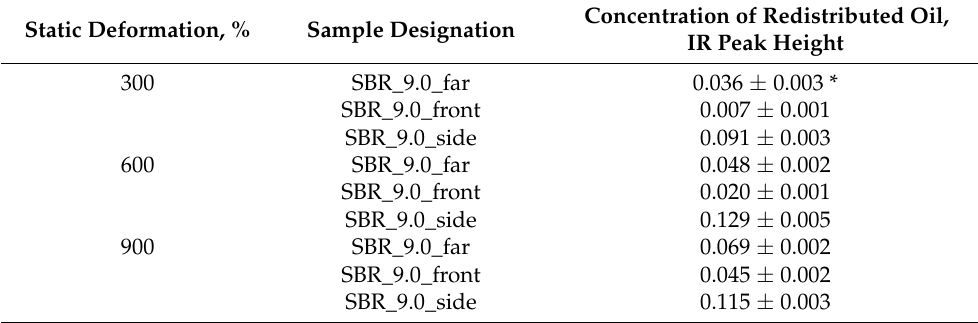
Table 2. Redistributed oil concentration for various static deformation programmes. Concentration of Redistributed Oil, Static Deformation, % Sample Designation IR Peak Height 300 SBR_9.0_far 0.036 ± 0.003 * SBR_9.0_front 0.007 ± 0.001 0.091 ± 0.003 600 SBR_9.0_far 0.048 ± 0.002 0.020 ± 0.001 0.129 ± 0.005 900 SBR_9.0_far 0.069 ±